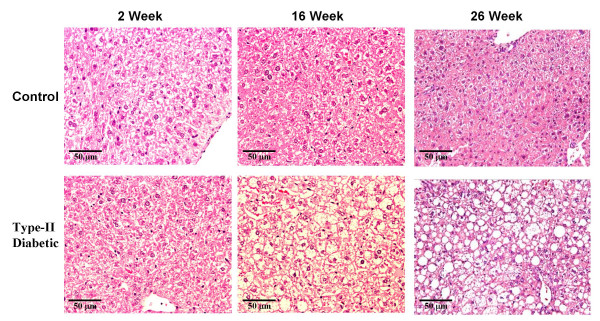
Steatosis in liver of high-fat diet fed mice. Mice were weaned directly onto either standard chow or a high-fat diet and maintained on the respective diets for up to 26 weeks. The mice were sacrificed and liver tissue isolated. Histology was performed on H&E stained liver tissue as described.